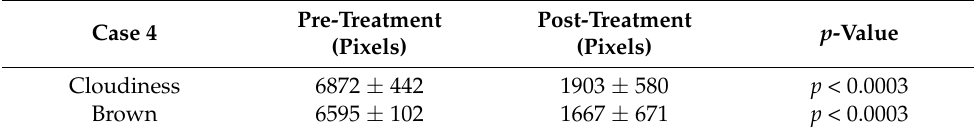
Table 4. In Case 4, the cloudiness and brown areas from the pre-treatment (before applications) and post-treatment (after seven applications) images were measured as pixels by digital image analysis. The analysis was performed three times, and the mean and standard deviations of the measurements were calculated (mean ± SD). The significance of the differences in areas before and after treatment was evaluated with p -values by t -test.